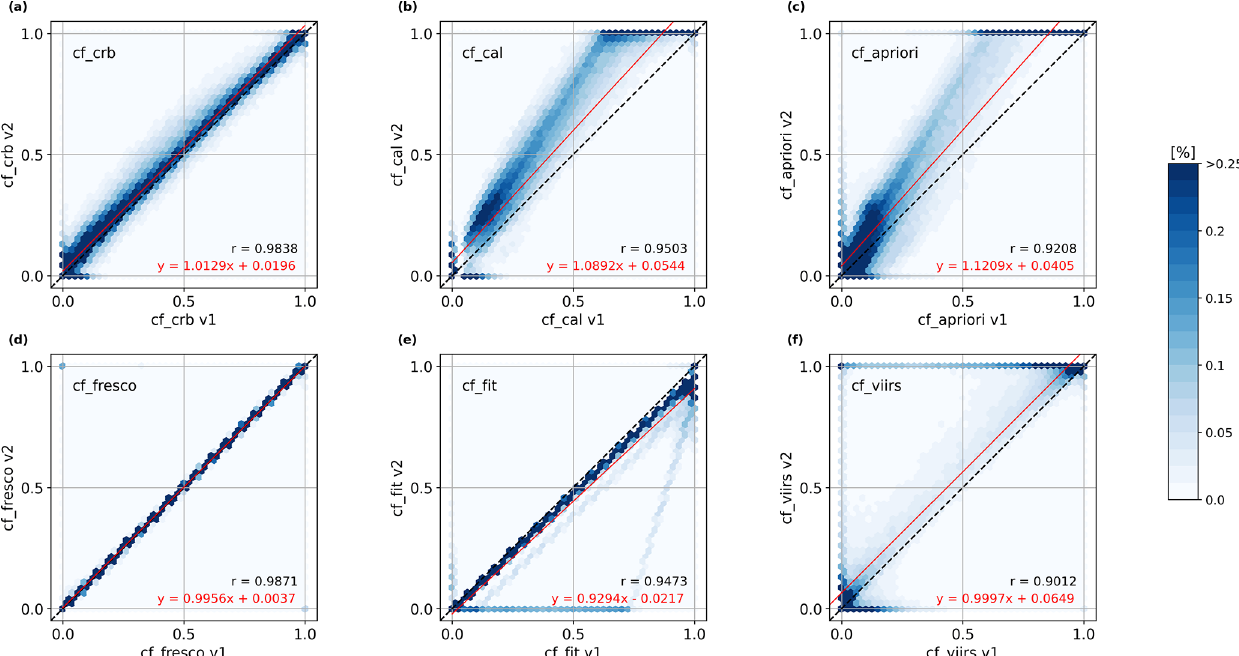
Figure 2. Density histograms between the version 1 and version 2 cloud fractions from (a) ROCINN CRB, (b) ROCINN CAL, (c) OCRA a priori, (d) FRESCO, (e) the NO 2 fitting window, and (f) VIIRS for Europe and the spring day (4 April